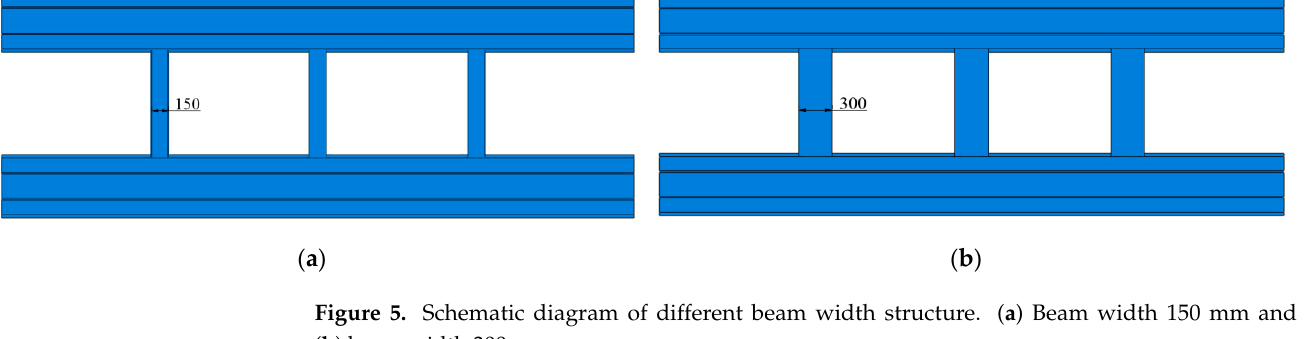
( b ) ( c ) Figure 6. Schematic diagram of the structure of the lower slab of the rail seats. ( a ) 80 mm, ( b ) 100 mm, and ( c ) 120 mm.